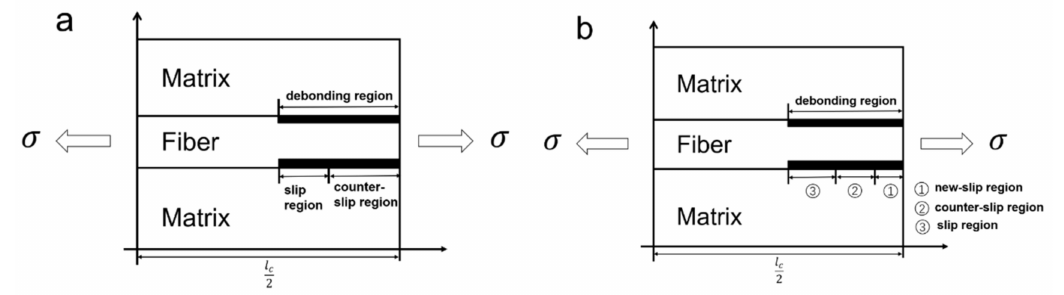
Figure 1. Unit cell of damaged CMCs upon ( a ) unloading and ( b ) reloading.